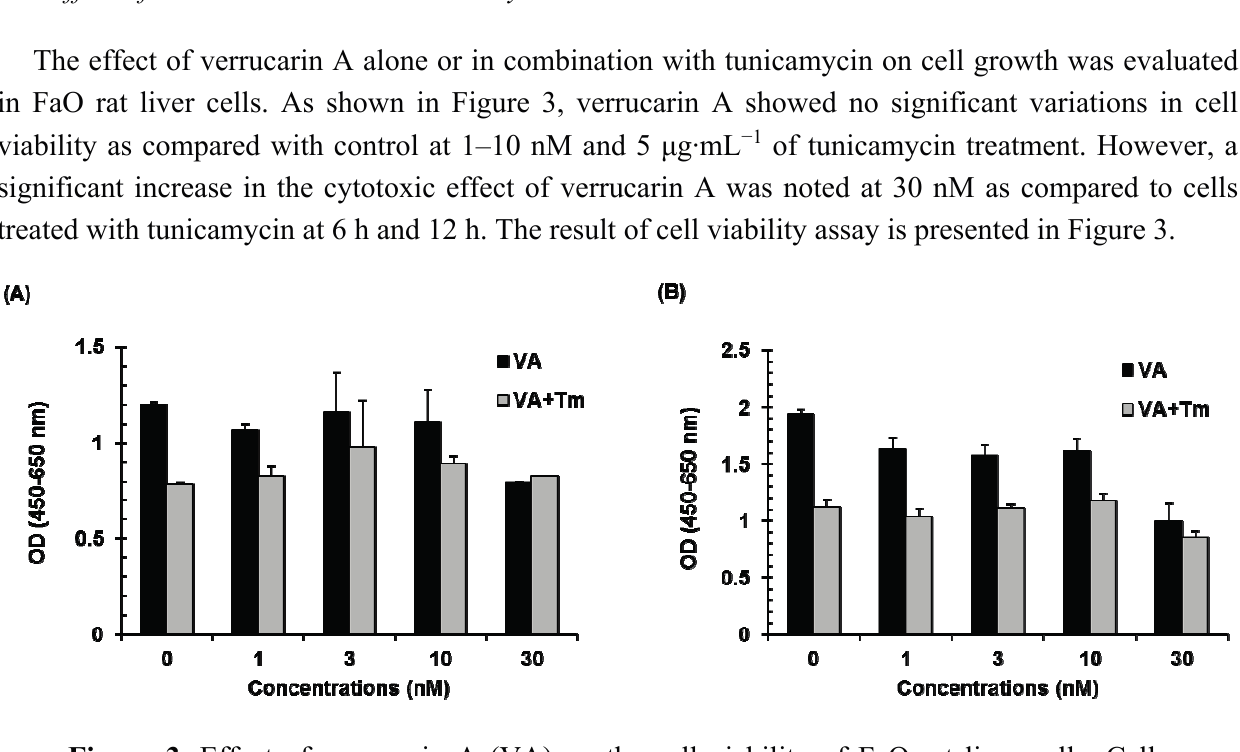
Figure 3. Effect of verrucarin A (VA) on the cell viability of FaO rat liver cells. Cells pre-treated with 1, 3, 10, and 30 nM of verrucarin A or not with each dose for 1h were exposed to 5 μ g·mL − 1 tunicamycin (Tm) for 6 h ( A ) and 12 h ( B ). Subsequently, cell viability was measured with cell viability assay kit. Bars represent means ± SE from representative triplicate